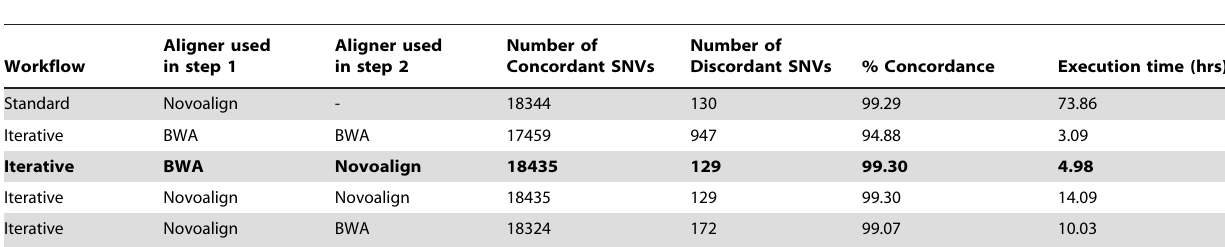
Table 1. Concordance of SNP data with variants from standard and iterative workflows for sample NA12878.